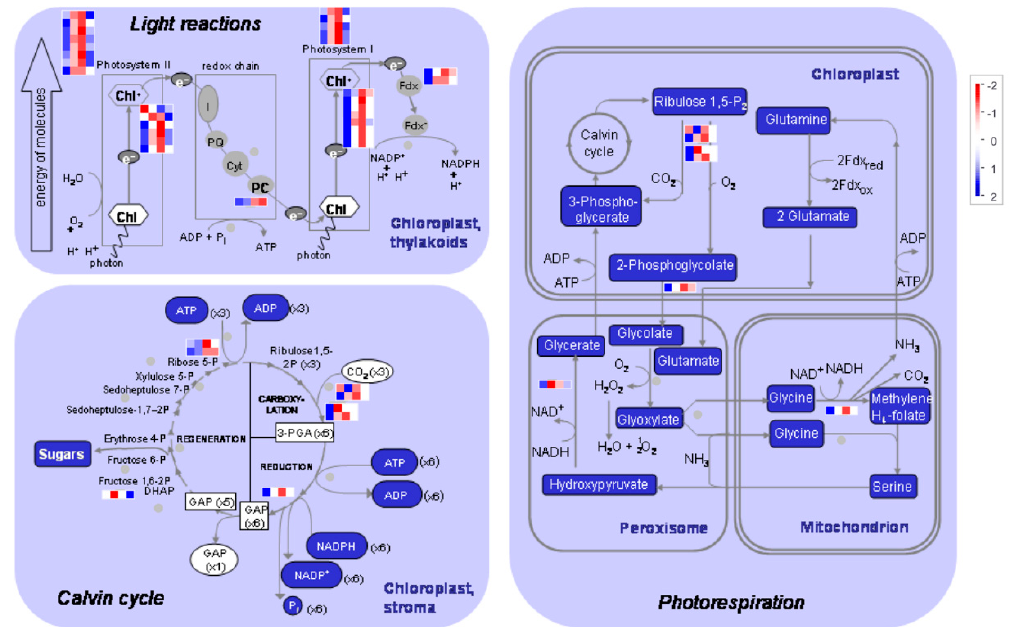
Figure 4. Diagram of DE genes related to photosynthesis pathways. The analysis is performed in the MapMan software. The Fragments Per Kilobase of exon per Million fragments mapped (FPKM) values are transformed by 2-based logarithm and then normalized by row as scaled by the color bar. Each row indicates a single gene, and the cells (from left to right) represent the samples from 0, 6, 12, and 24 h after salt treatment, respectively.